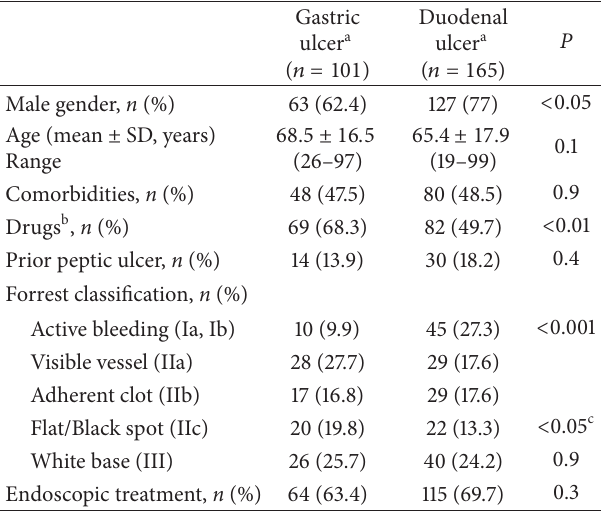
Table2:Differentialclinicalcharacteristicsaccordingtoendoscopic